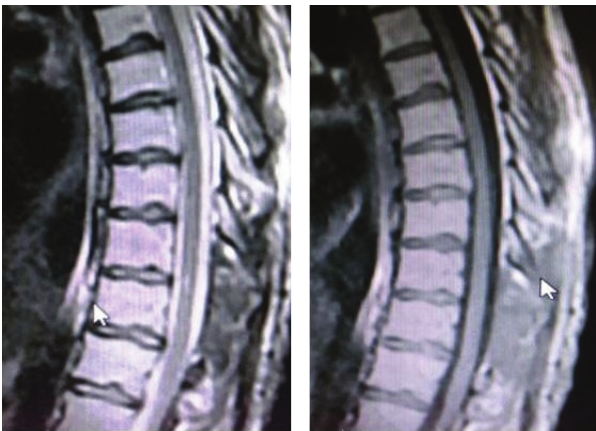
Figure 3: Postoperative thoracic sagittal T1-T2 MRI.